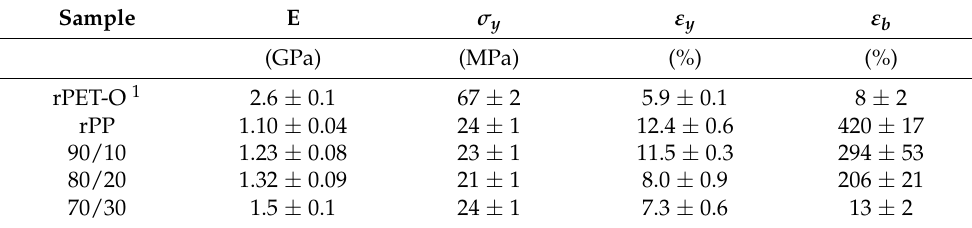
Table 3. Uniaxial tensile properties of rPP/rPET-O samples tested at 1 mm·min − 1 crosshead speed.